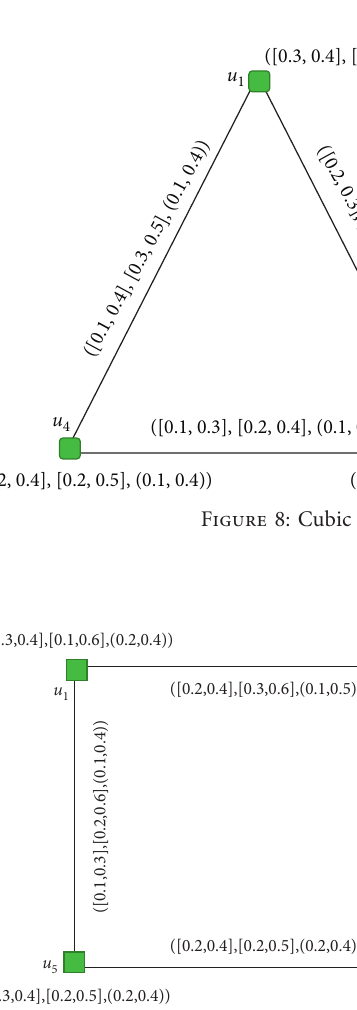
Figure 9: Cubic intuitionistic fuzzy